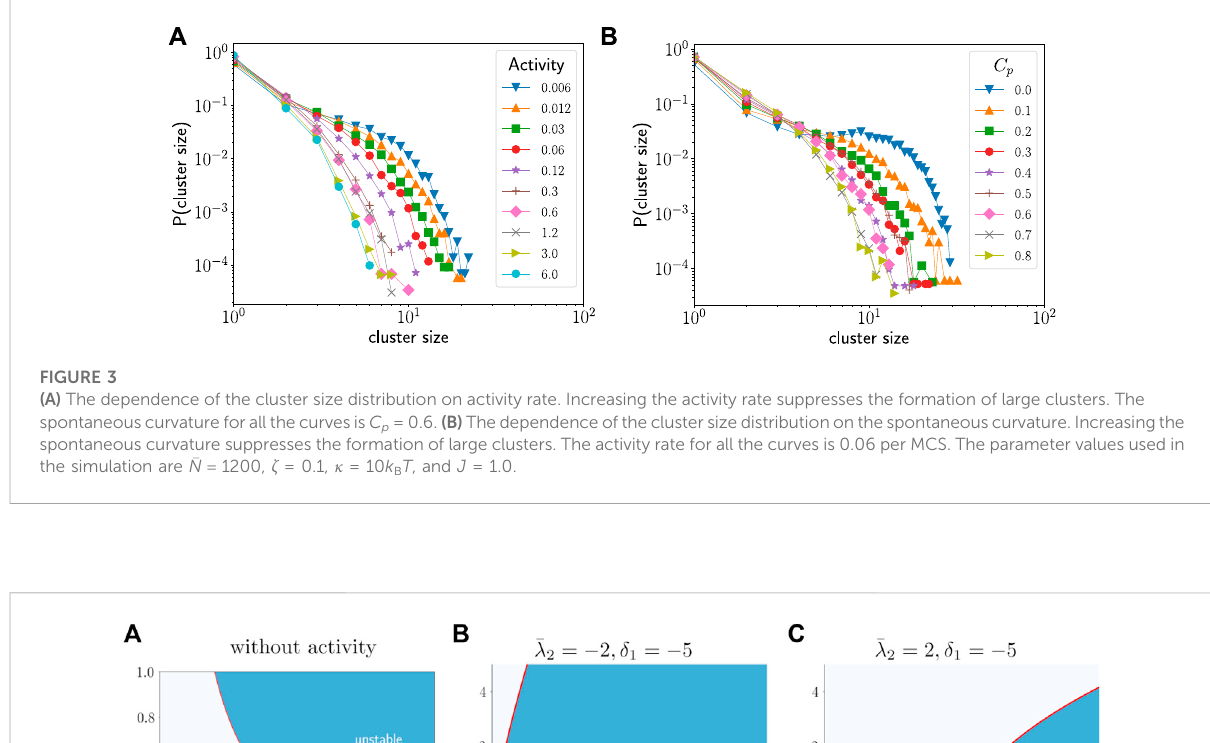
(cid:1) λ Figure 4 (bottom panel) shows the 2 is positive, diagram for three values of (cid:1) phase diagrams for δ 1 = 5 (not reported in Figure 4) were C p and (cid:1) qualitatively similar to those for δ 1 = − 5. C p (Figure 4C).